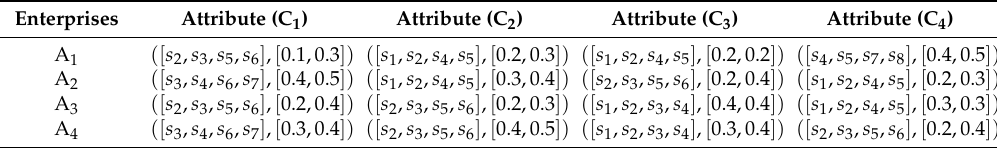
Table 2. The attribute values of each attribute with respect to four enterprises given by expert e 2 .